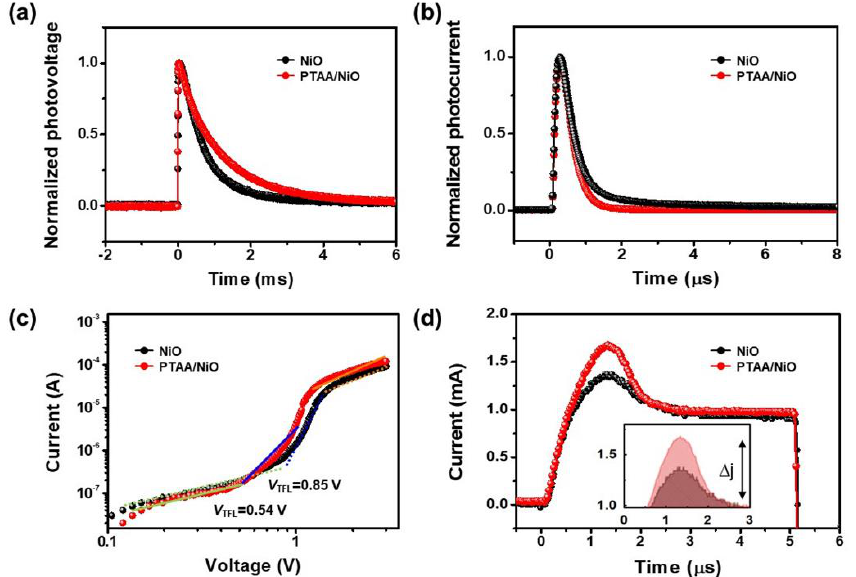
Figure 7. ( a ) Normalized TPV curves and ( b ) TPC curves of NiO and PTAA/NiO bilayer-based PSCs. ( c ) Dark J – V curves of NiO and PTAA/NiO bilayer-based hole-only devices. ( d ) Photo-CELIV measurement of PSCs (the inset indicates the extracted charges).